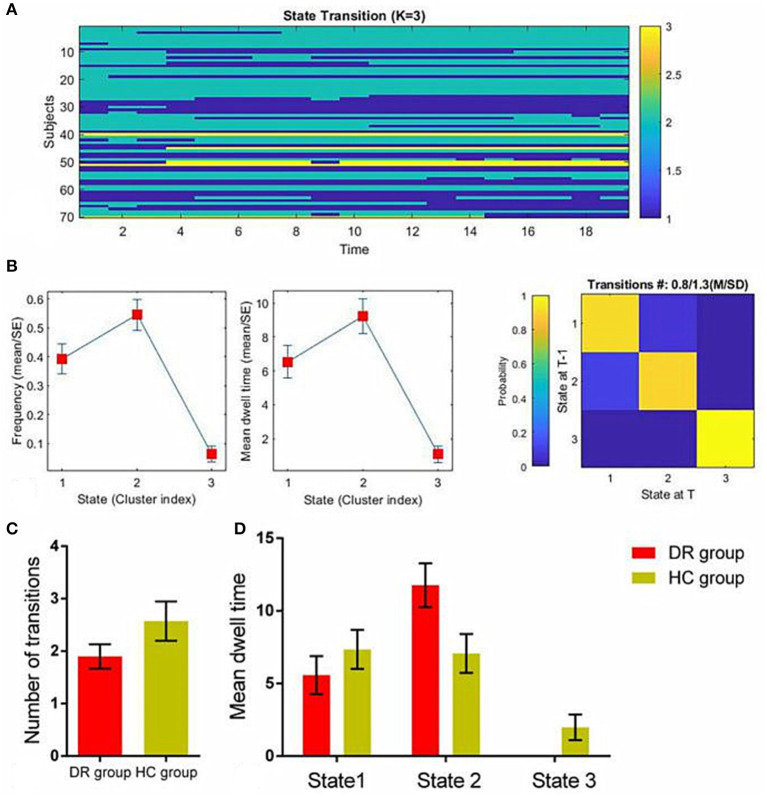
The temporal properties of dALFF patterns between the DR group and HC group. The K-means clustering method with three clusters (A). Transition matrices of different states (B). The number of transitions between states (C). Mean dwell time (D). dALFF, dynamic amplitude of low-frequency fluctuation; DR, Diabetic Retinopathy; HC, Health Controls.